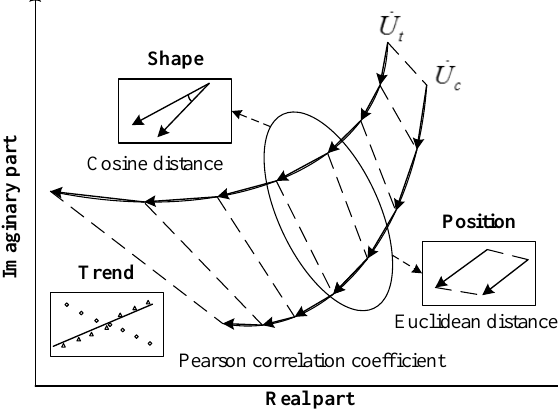
Figure 3. Spatial attribute of node voltage trajectories.